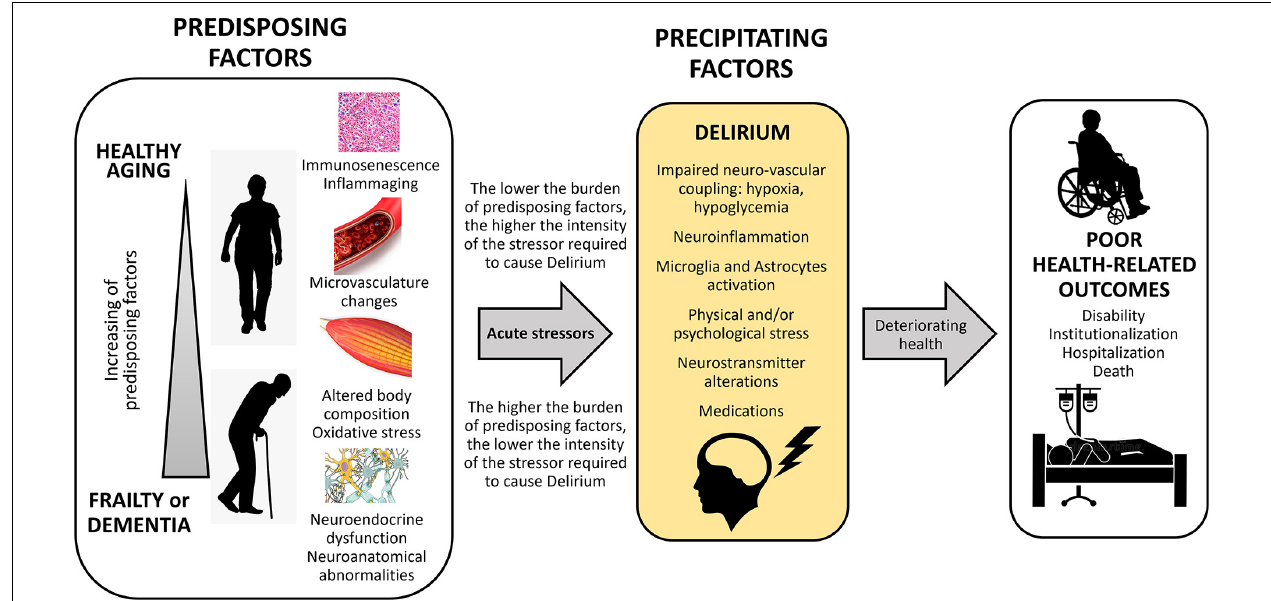
FIGURE 1 | Conceptual framework of predisposing and precipitating factors leading to delirium after an acute stressor, and hesitating in poor health-related